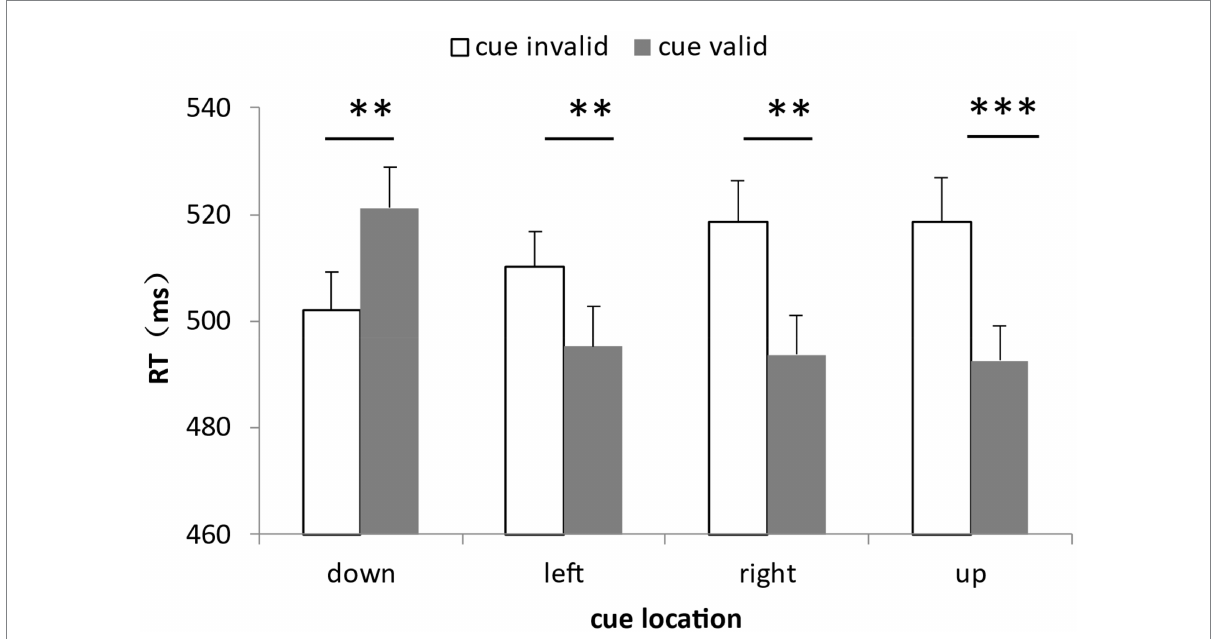
FIGURE 4 Interaction between cue validity and cue location in Experiment 1. When the cue appeared in the lower position, the response when the cue was invalid was faster than that when the cue was valid; when the cue appeared in other places, the response when the cue was invalid was slower than when the cue was valid (* p < 0.05, ** p < 0.01, *** p < 0.001, the same